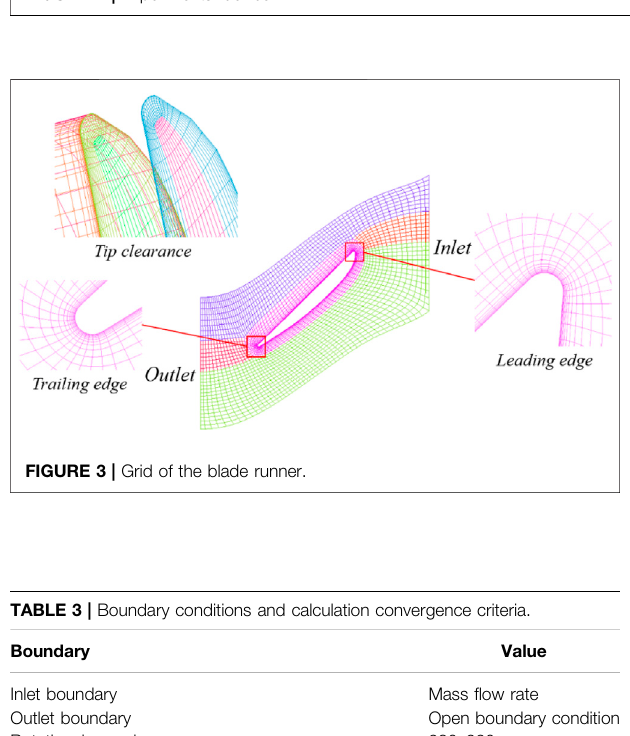
FIGURE 2 | Experimental device.